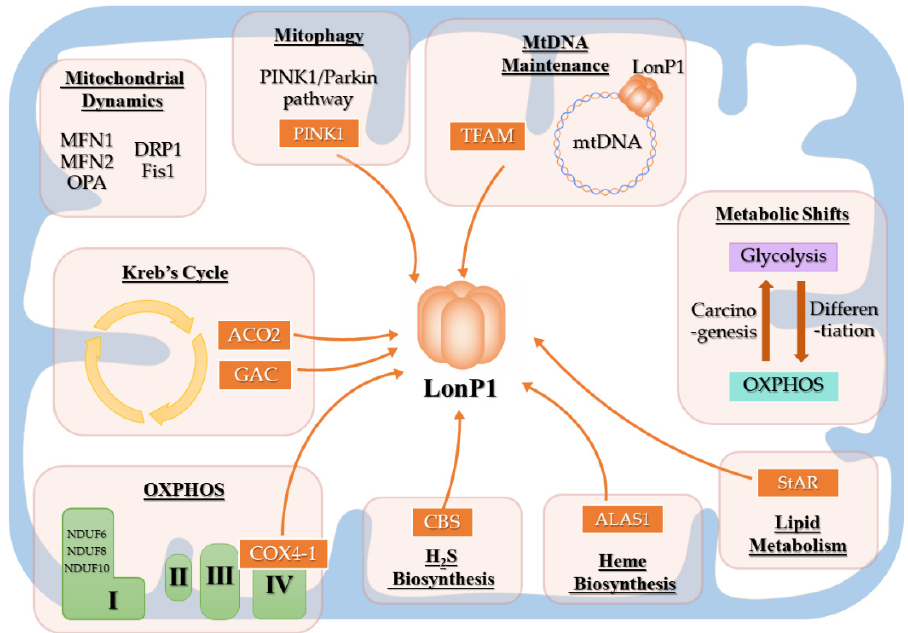
Figure 2. A schematic representation of the LonP1 function. The black underlined words are the functions involving LonP1, and the orange boxes with arrows pointing to LonP1 are the substrates proteolyzed by LonP1.